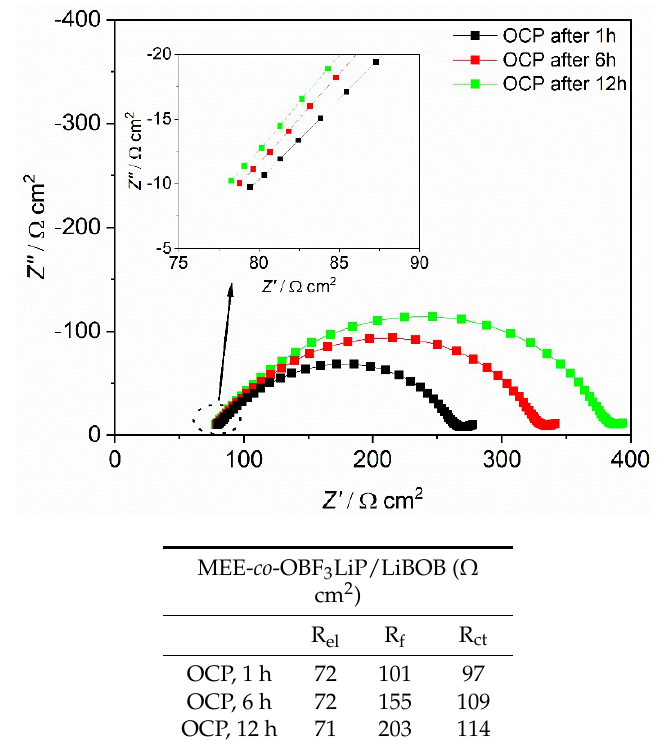
Figure 11. Impedance spectra of Li|MEE- co -OBF 3 P/LiBOB|Li at 60 °C after 1, 6, and 12 h under OCP conditions. The table lists the corresponding R el , R f , and R CT at different stage. R el is the electrolyte bulk resistance and R int is the interface resistance, which consists of R f and R CT .